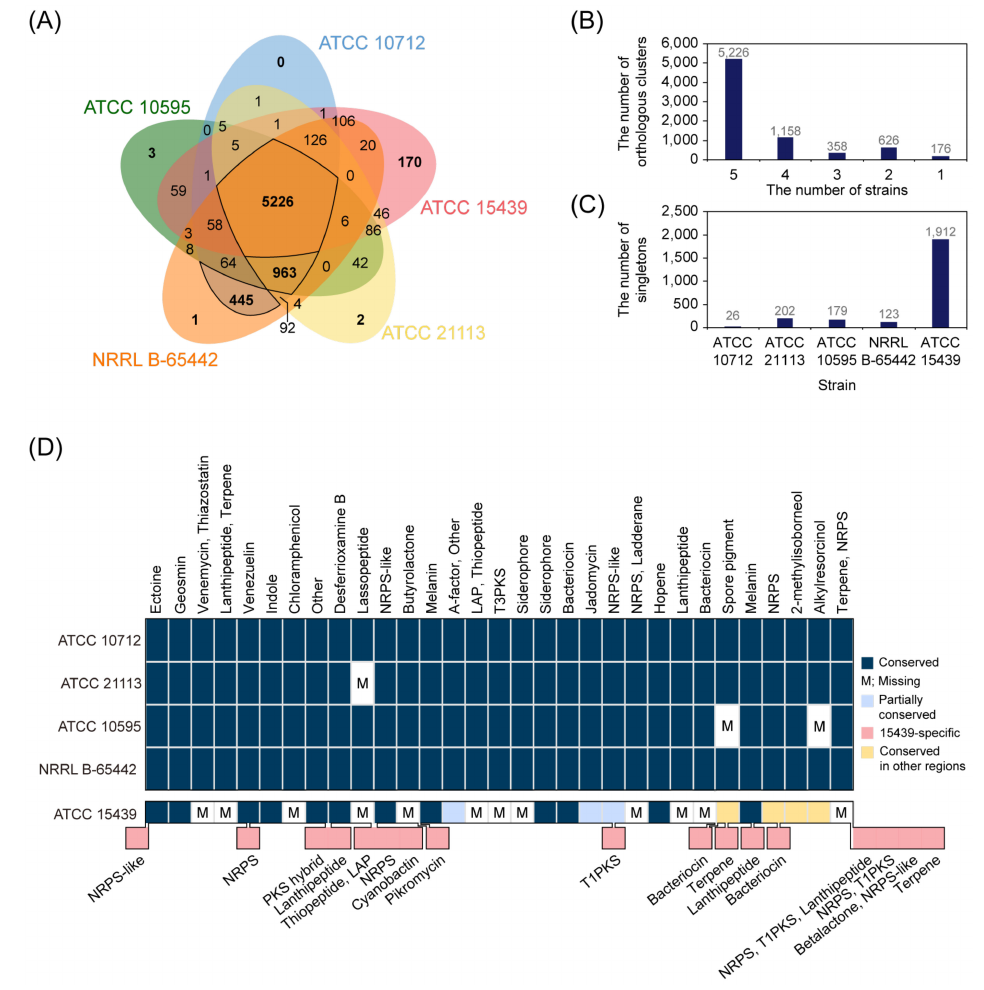
Figure 4. Genome comparison of S. venezuelae strains. ( A ) The distribution of orthologous genes among the five S. venezuelae strains. ( B ) The number of orthologous genes according to the number of strains. ( C ) The number of singletons of each strain. ( D ) The predicted secondary metabolite biosynthetic gene clusters (smBGCs) of S. venezuelae strains. NRPS, non-ribosomal peptide synthetase; LAP, linear azol(in)e-containing peptides; T3PKS, type III polyketide synthase; PKS, polyketide synthase; T1PKS, type I polyketide